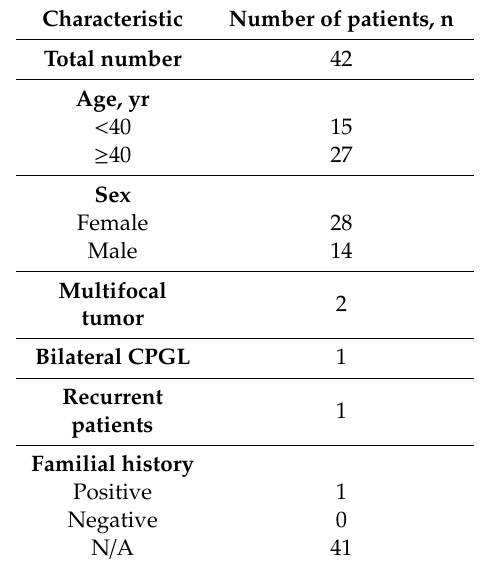
Table 2. Clinicopathologic characteristics of patients with